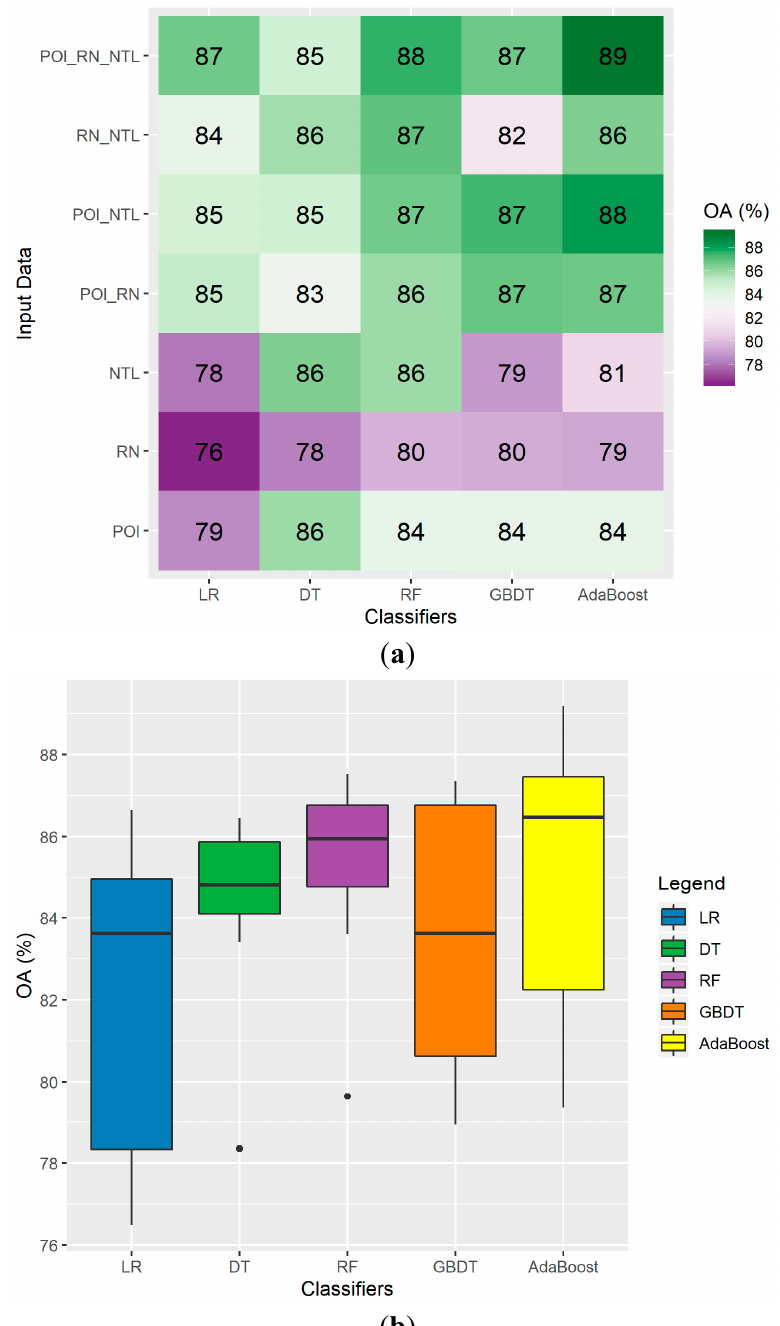
Figure 8. The ( a ) heat map and ( b ) boxplot of overall accuracy (OA) for 35 combinations between the five classifiers and seven types of input data using the